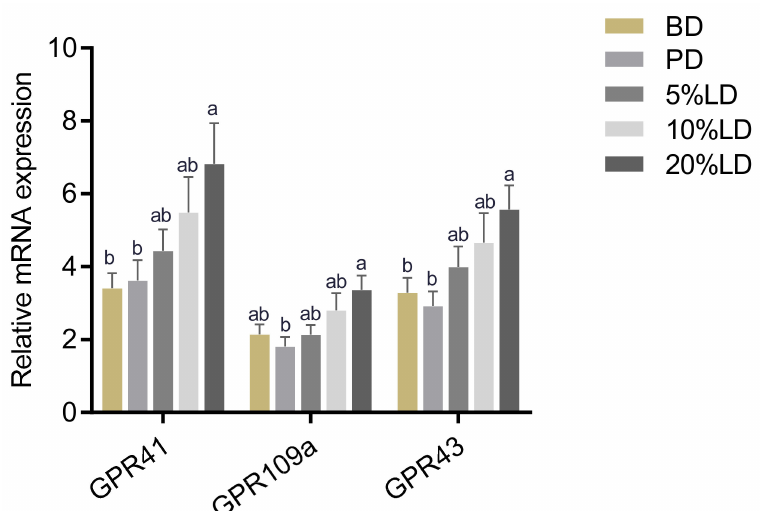
Figure 5. E ff ect of lentil supplementation on relative mRNA expression of colon SCFA receptors (GPR 41, GPR 43 and GPR 109a). Values are mean ± SEM ( n = 12 / dietary group). Data for each gene were normalized to the expression of the housekeeping gene RPLP0. Bars not sharing a lower-case letter di ff er ( p < 0.05). BD = basal diet; PD = pectin diet; LD = lentil